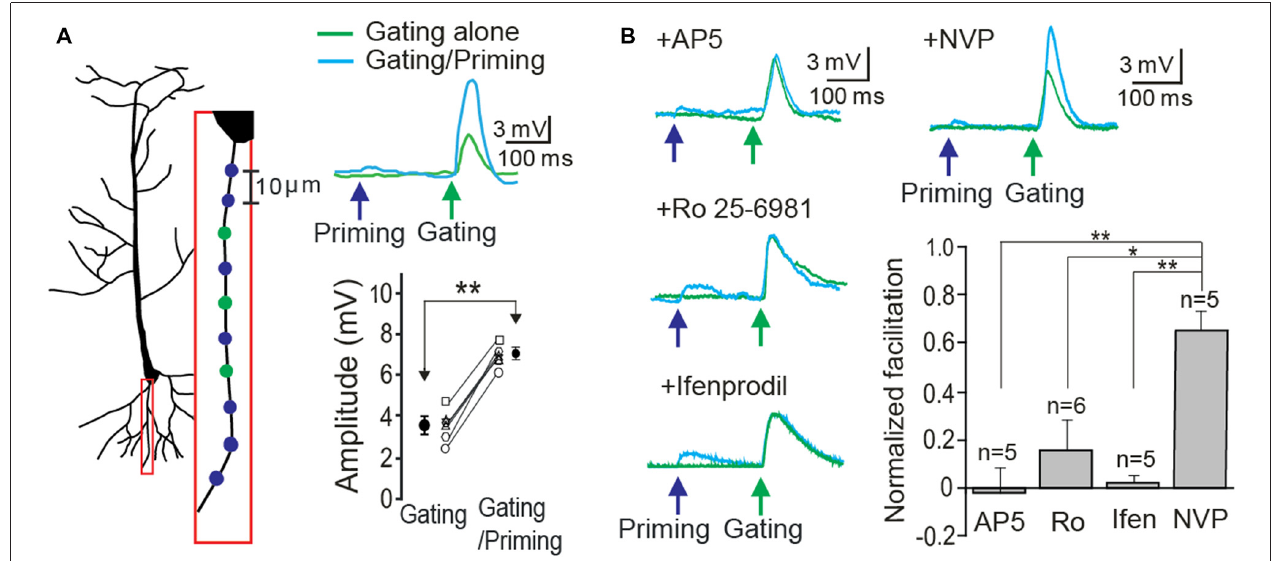
FIGURE 2 | Short-term postsynaptic plasticity (STPP) on a hippocampal dendrite. (A) Illustration of a CA1 pyramidal neuron and priming (blue)/gating (green) glutamate uncaging spots in a basal dendrite (left). The representative responses to priming plus gating (cyan trace) and gating alone (green trace) glutamate uncaging were shown as photoactivated excitatory postsynaptic potentials (EPSPs). Read-out facilitation was observed when a priming photolysis proceeded a gating photolysis ( n = 6 cells). (B) Neuronal facilitation was completely blocked by AP5 (an NMDAR blocker), Ro 25-6981 and Ifenprodil (NR2B blockers), while it remained by NVP-AAM077 (an NR2A blocker). Error bars represent SEM. ∗ p < 0.05; ∗∗ p <